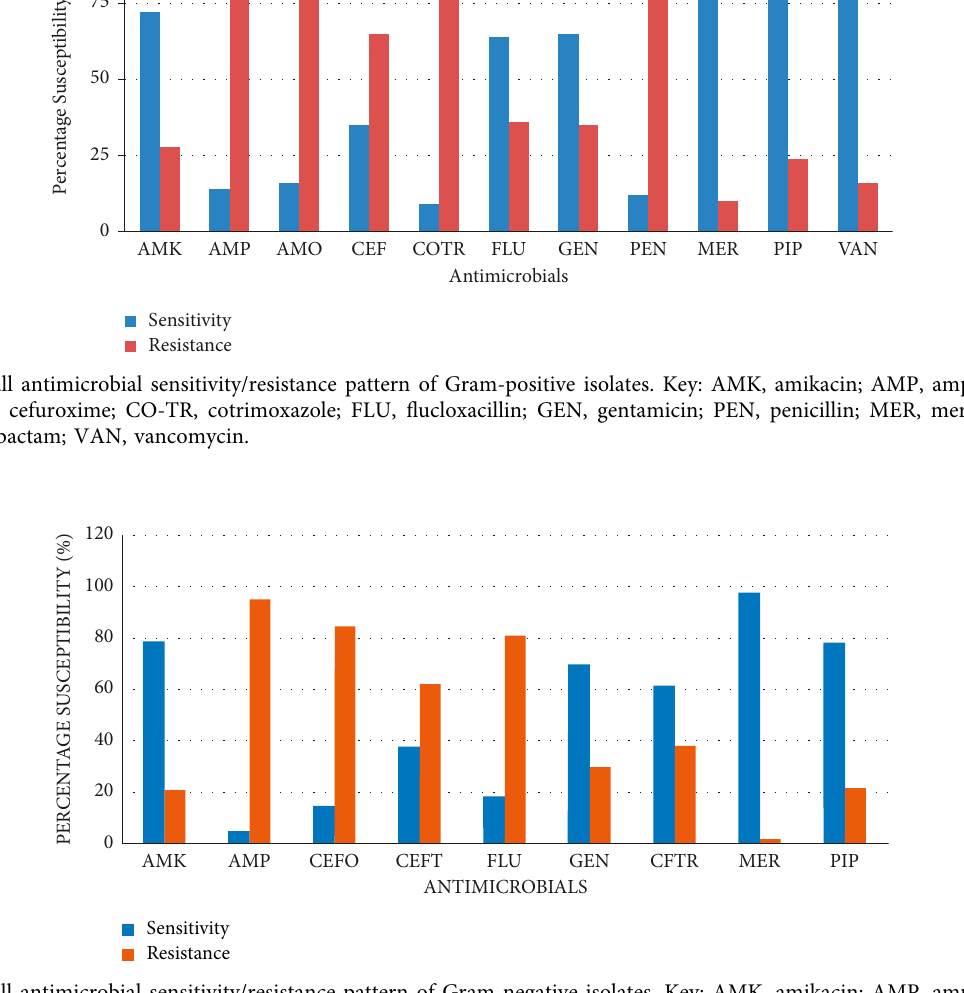
Figure 4: Overall antimicrobial sensitivity/resistance pattern of Gram-negative isolates. Key: AMK, amikacin; AMP, ampicillin; AMO, amoxiclav; CEF, cefuroxime; CO-TR, cotrimoxazole; FLU, flucloxacillin; GEN, gentamicin; PEN, penicillin; MER, meropenem; P/T, piperacillin/tazobactam.